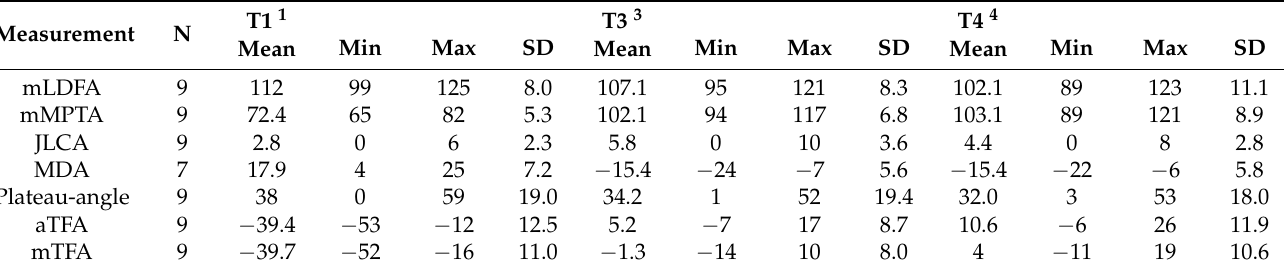
Table 3. Radiographic results of the short-term follow-up in 5 patients (9 limbs).